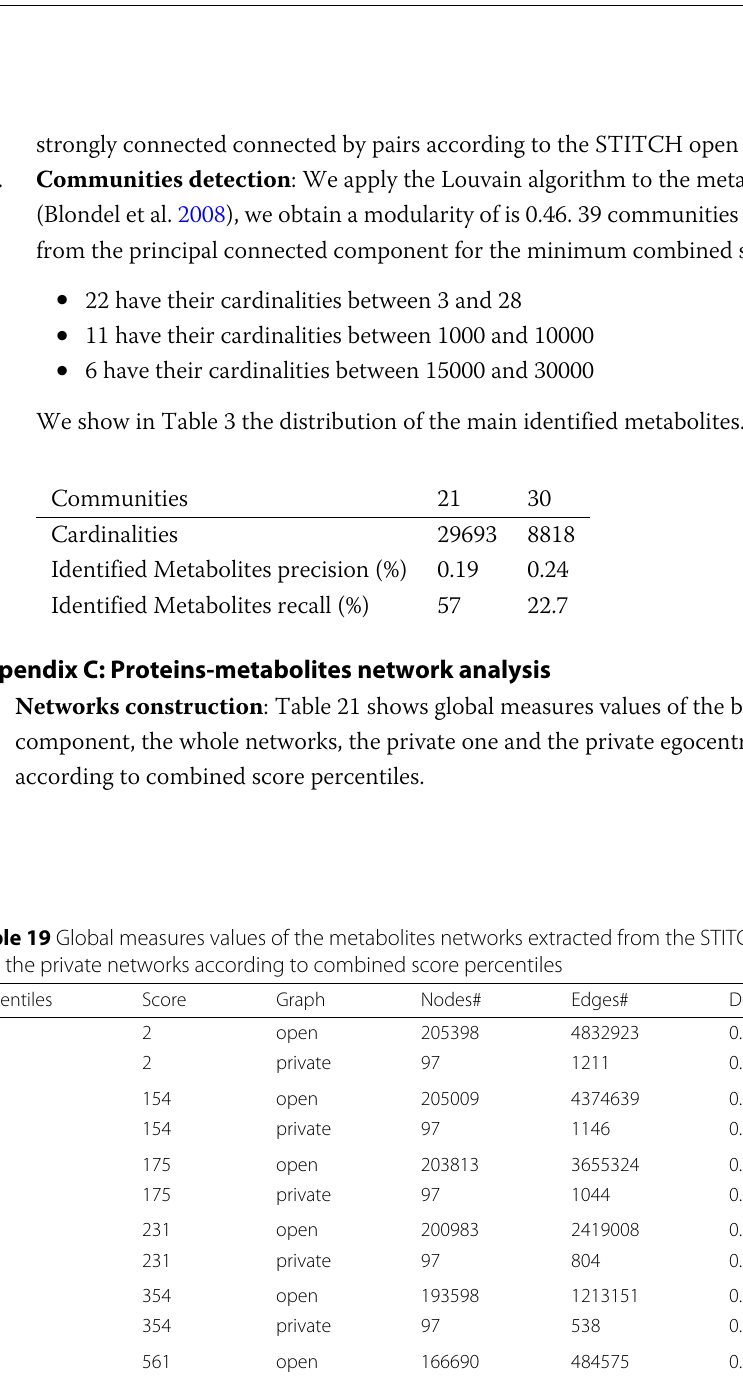
Table 18 Communities detection with the Louvain algorithm, Modularity is 0.38 Communites 1 2 3 4 5 9 7 8 Cardinalities 1481 1191 3848 5050 1820 3769 Identified Proteins precision ( PV P %) 0.54 0.59 0.52 Identified Proteins recall (%)